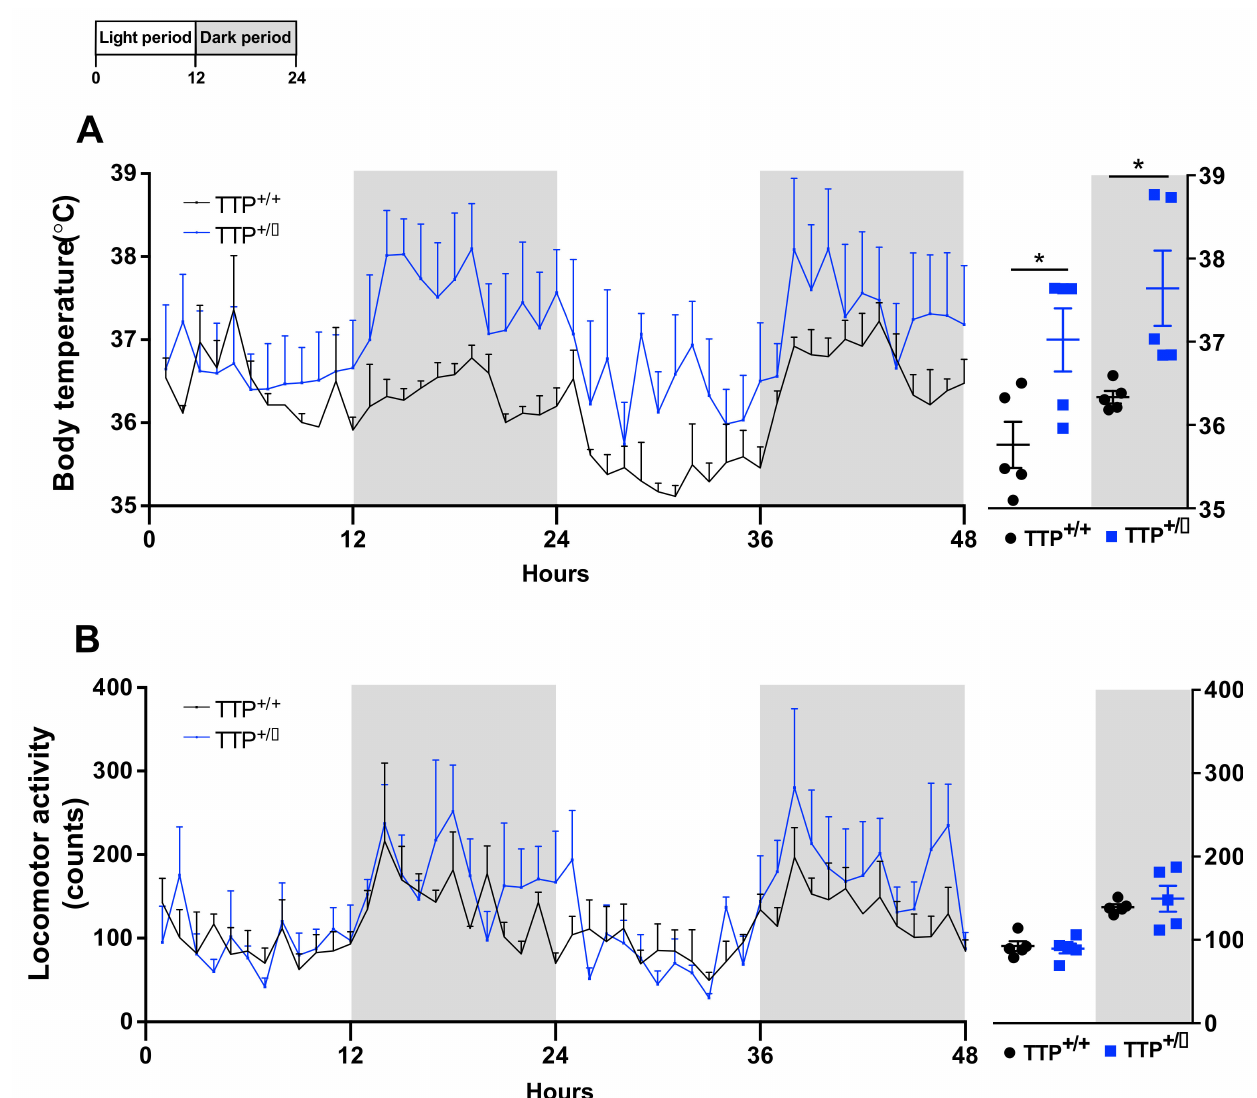
Figure 6. TTP-deficient mice display signs of hyperthermia. Core body temperature and physical activity were determined using telemetry probes. ( A ) An elevation of core body temperature was observed in the TTP-deficient mice compared to that in wild-type mice. ( B ) Locomotor activity was not altered in the TTP-deficient mice compared to that in wild-type control mice. Data are presented as the mean ± SEM. n = 5 mice per group. * p < 0.05. SEM; standard error of the